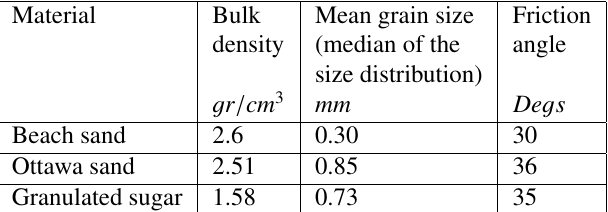
Table 1. Properties of the particles used in the experiment.